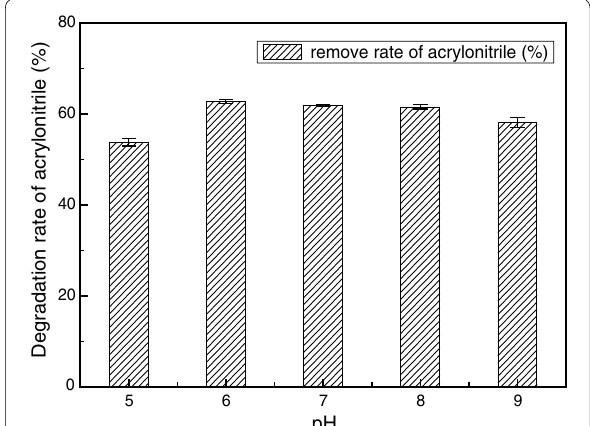
Fig. 7 Influence of pH on acrylonitrile biodegradation rate. The rate of acrylonitrile degradation increased when the pH value was increased from 5 to 6. The optimal pH values for ZJUTB06-99 to degrade acrylonitrile were from 6 to 8